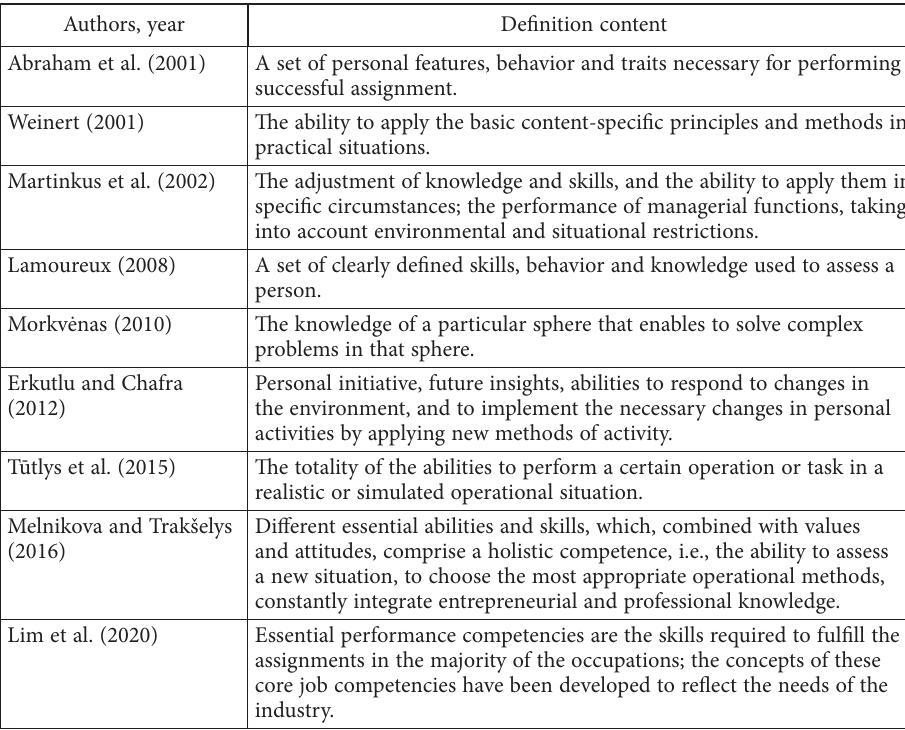
Table 1. Competence definitions (compiled by the